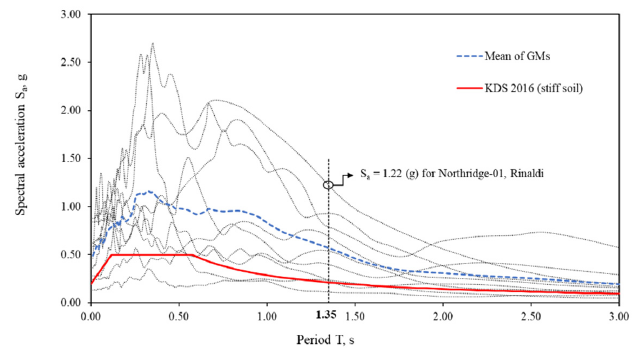
Figure 5. Elastic response spectra and design response spectra.